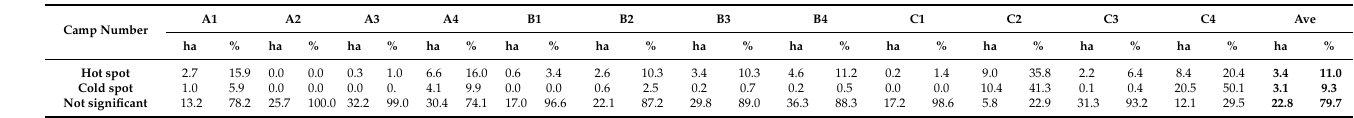
Table 2. The area (ha and %) in each grazing camp that was identified as either hotspot, cold spot or not significant.